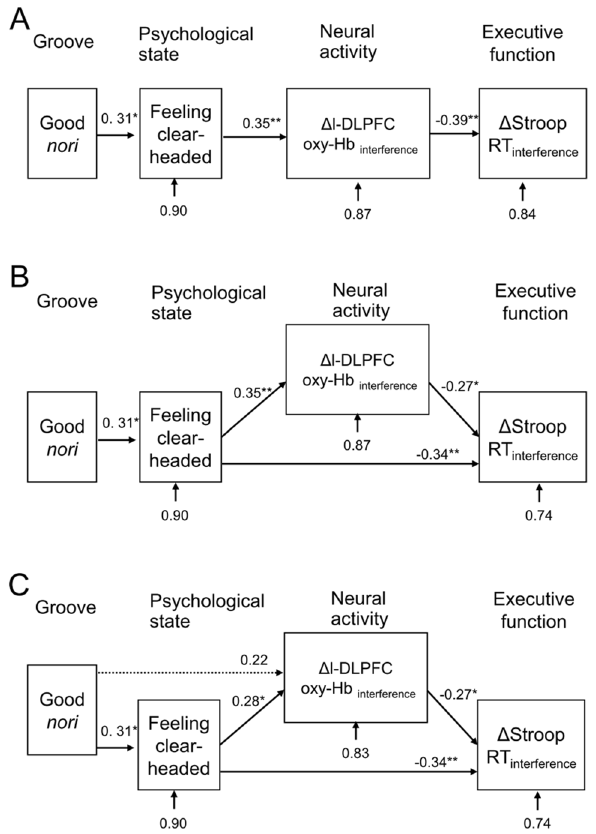
Figure 4. Path analyses. ( A ) The first model. ( B ) The Second model. ( C ) The third model. Variables are “Good nori ”, “Feeling clear-headed”, Δl-DLPFC oxy-Hb interference , and ΔStroop RT interference . All variables represent condition differences (GR—WM). ** P < 0.01, * P <